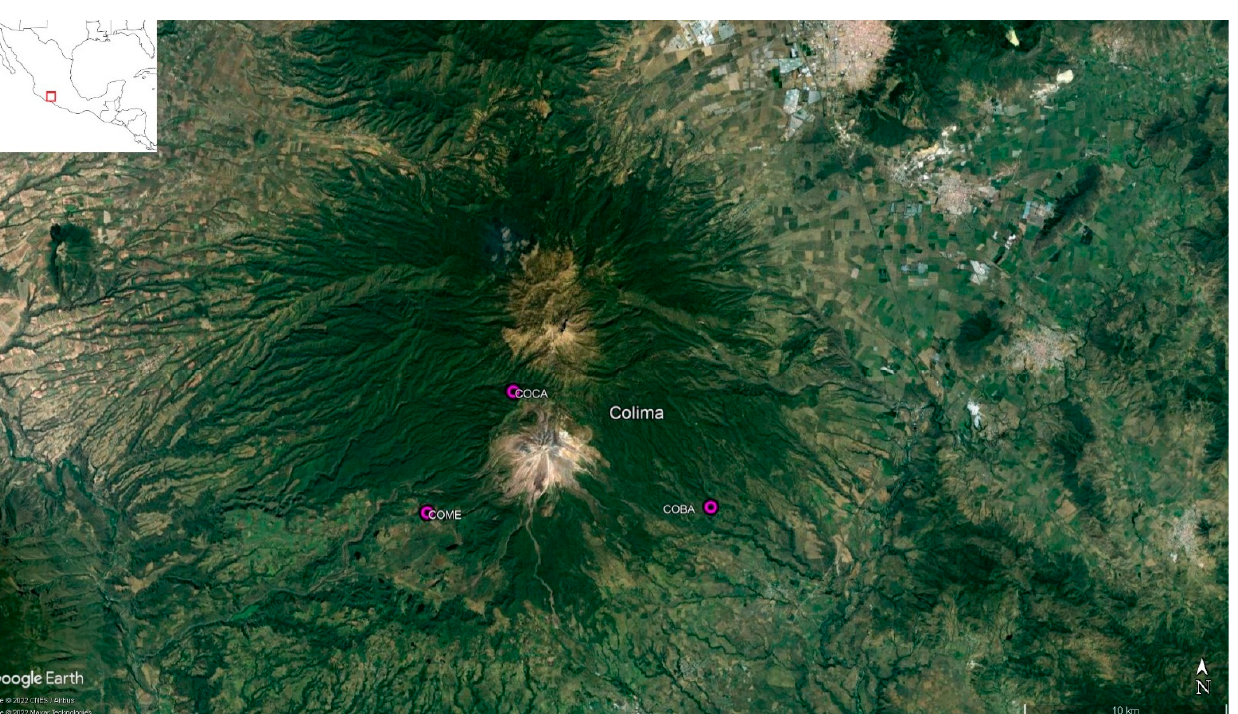
Figure 1. Map of the Neapolitan volcanoes (Vesuvius, Campi Flegrei, and Ischia) with the seismic stations (circles in blue for Vesuvius, red for Campi Flegrei, and yellow for Ischia) used for the anal- ysis.